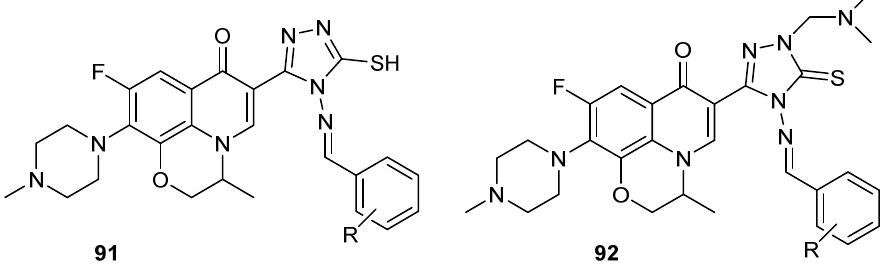
Figure 13. Chemical structure of hybrid fluoroquinolone-Schiff